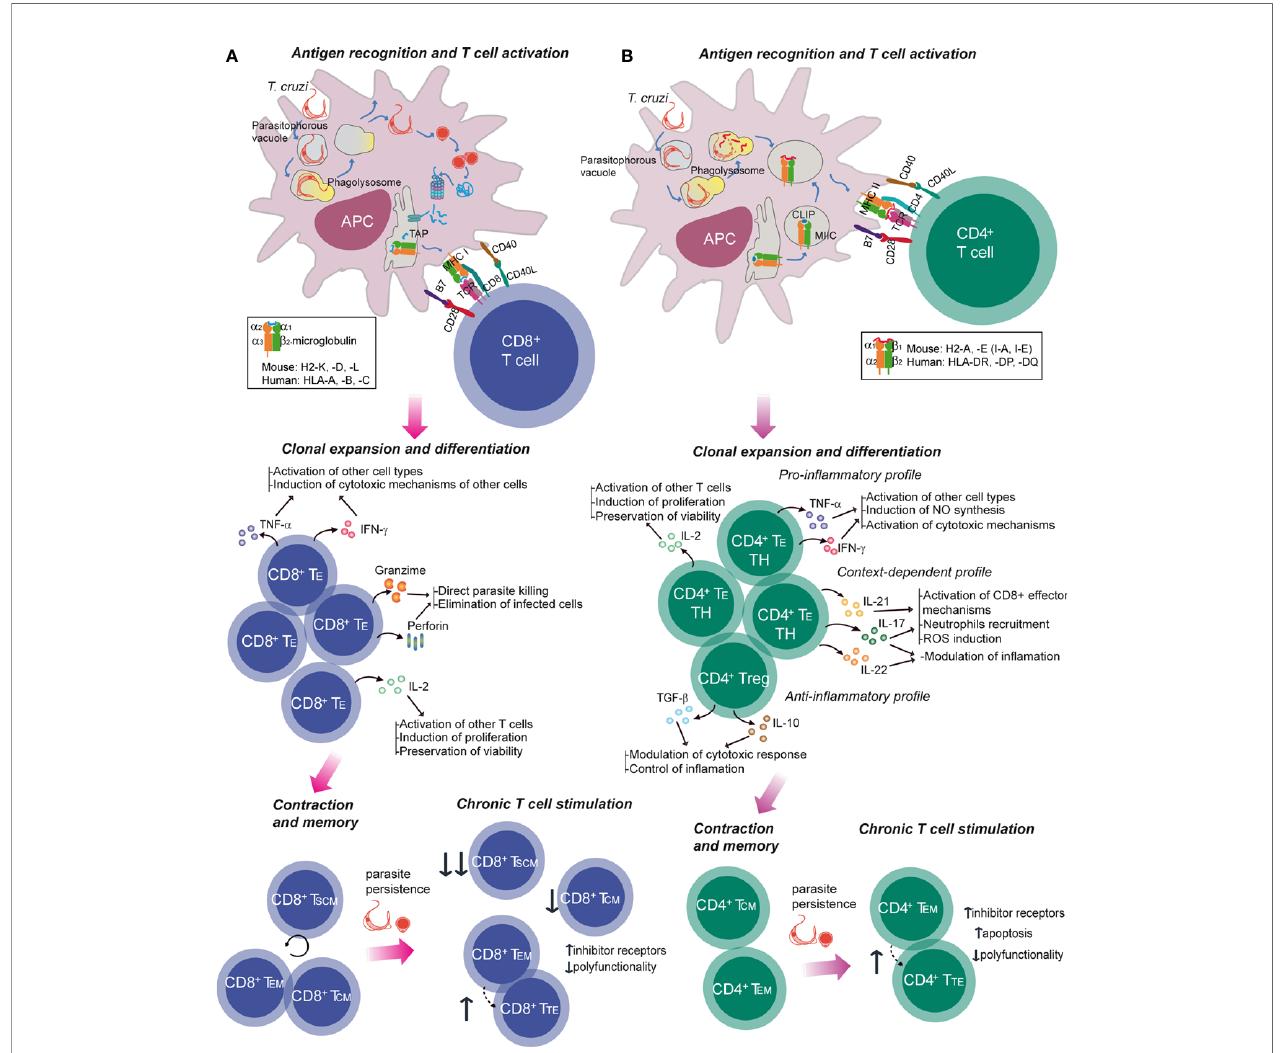
FIGURE 2 | Speci fi c T cell response in Chagas disease. The activation of T-cell immune responses is mediated by APCs, which deliver antigen-speci fi c and costimulatory signals. Trypanosoma cruzi trypomastigote invades the host cell or is passively internalized, leading to the formation of the parasitophorous vacuole which fuses with a lysosome resulting in a phagolysosome. The parasite can escape to the cytoplasm (A) where it differentiates into the amastigote form and its proteins are targeted for proteosomal degradation. Peptides generated are then imported into the endoplasmic reticulum (ER) to be presented to CD8 + T cells in the context of MHC class I molecules. These molecules consists of a b 2-microglobulin and a polymorphic alpha chain which contains the peptide binding groove and it is encoded by one of the mouse H2-K , H2-D and H2-L class I MHC genes and human HLA-A , -B or – C class I MHC genes. (B) Class II MHC is made up of polymorphic a and b chains that form the peptide binding groove, each encoding in mouse H2-A and H2-E class II MHC loci and in human HLA-DR , -DP and -DQ class II MHC loci. In the class II MHC pathway, proteins from parasite are degraded and antigenic peptides are loaded onto the binding cleft from the MHC. Peptide- MHC complexes are then presented in the host cell surface to the CD4 + T cell. In both CD8 + and CD4 + T cells, activation generates the expansion and differentiation into effector speci fi c T cells (T E ), their survival and function being sustained by cytokines and soluble mediators. Following antigen clearance, contraction takes place with a numerical reduction of antigen-speci fi c cells. A subset of the activated T cells survives beyond this phase and differentiates into long-lasting memory T cells. During chronic infections, which entail persistent antigen exposure and/or in fl ammation, different degrees of dysfunctionality can be observed, including terminal differentiation and T cell exhaustion with progressive loss of effector functions and co-expression of inhibitor receptors. IL, interleukin; IFN, interferon; TNF, tumor necrosis factor; T H , T helper; Treg, regulatory T cell; T SCM , stem cell memory T